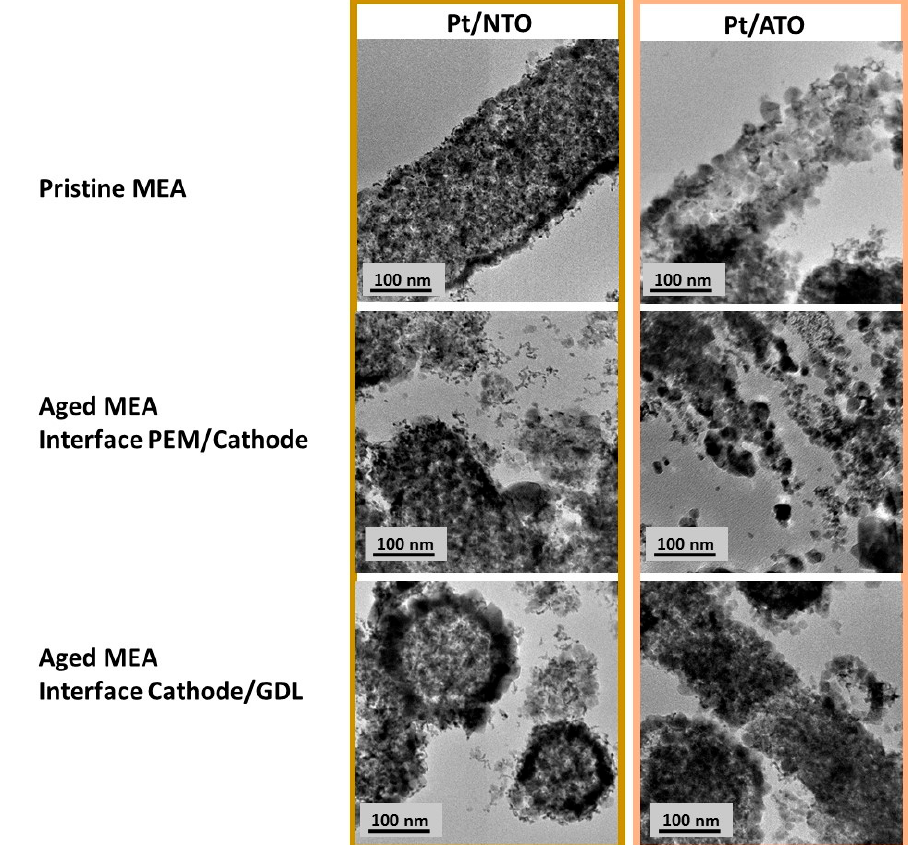
Figure 4. Representative TEM characterization of ultramicrotomed pristine/aged MEA to unravel morphological heterogeneities of ageing within the Pt/ATO and Pt/NTO cathode thickness.